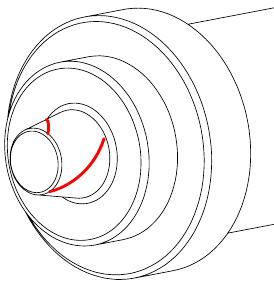
Figure 2. Definition, location and arrangement of the complementary material flow feature ( red ) as a superposition on the base tool